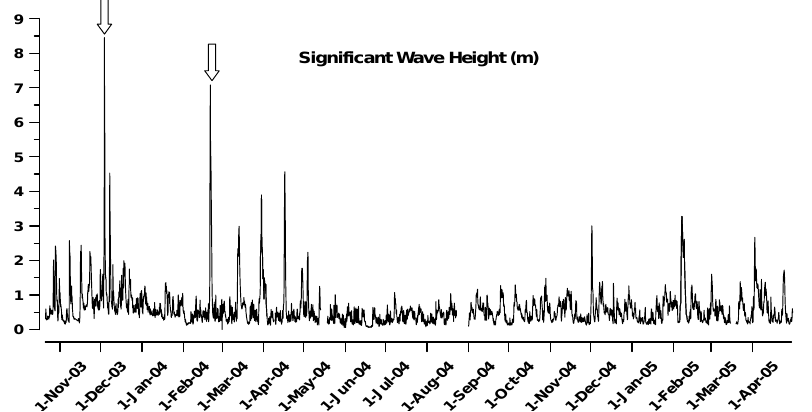
Fig. 2. Time series of significant wave height ( H s ) at the inner shelf in front of the Tˆet River mouth (see location in Fig. 1) from October 2003 to April 2005. Storm events correspond to H s peaks. Arrows point to the extreme E-SE storms with the highest H s peaks occurring in early December and late